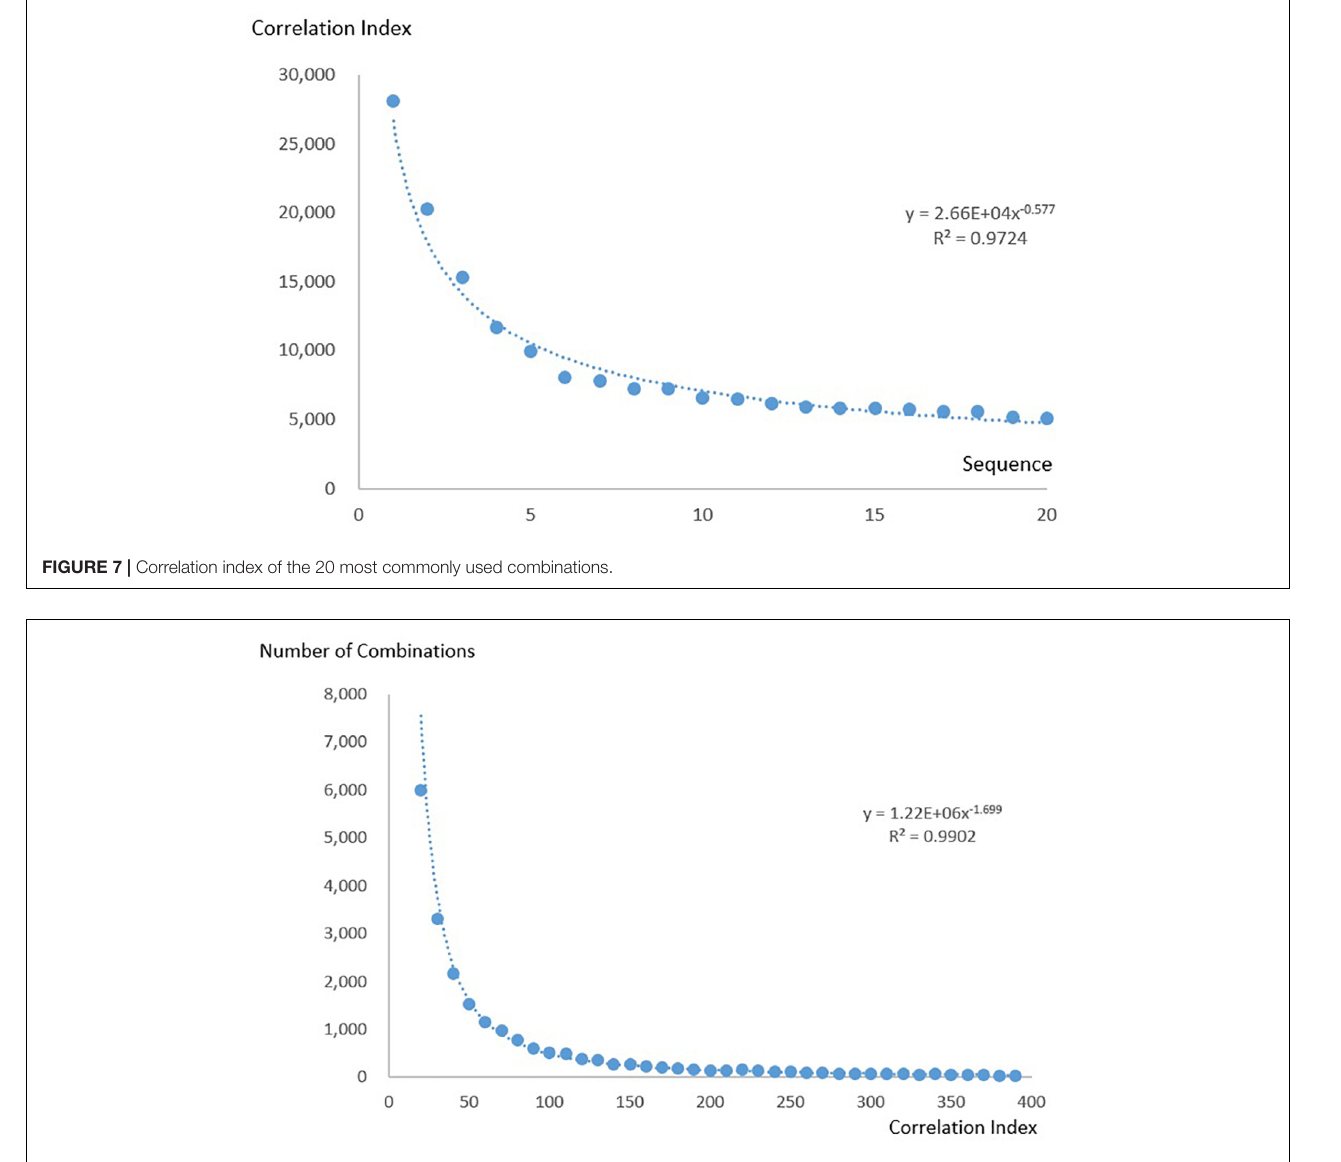
FIGURE 8 | The relation between the correlation index and the number of